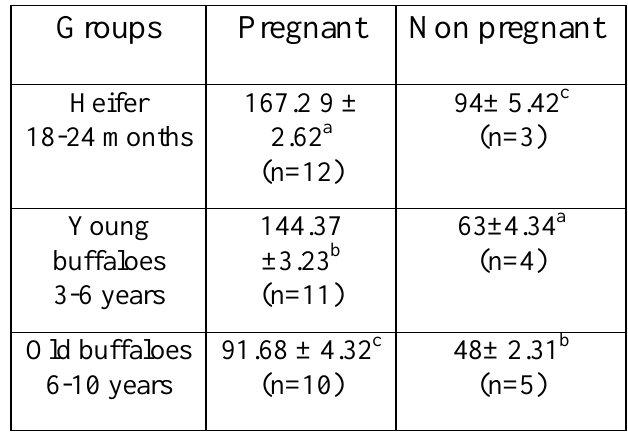
Table 2: The serum AMH concentrations from the day of insemination for the animals becoming pregnant and nonpregnant in the examination on the 30th day